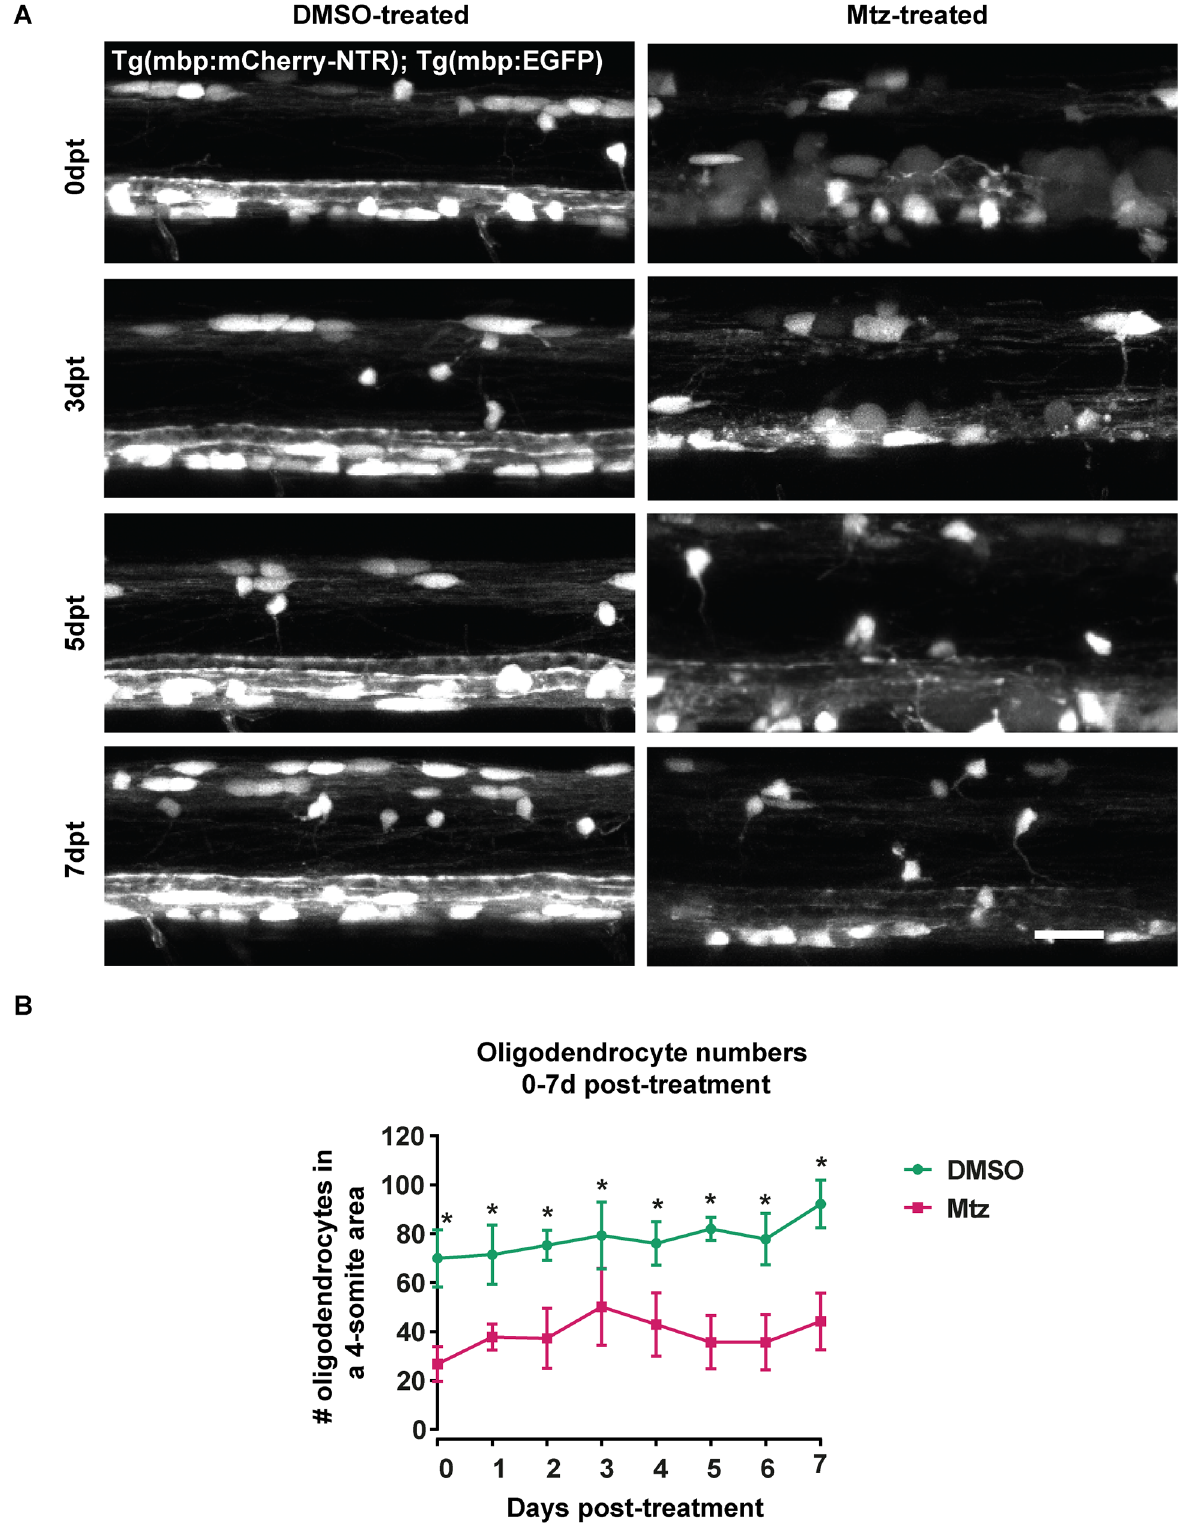
Fig 2. Oligodendrocyte numbers remain low in Mtz-treated Tg(mbp:mCherry-NTR) larvae for 7 days following treatment. A . Representative images from the spinal cords of DMSO- and Mtz-treated Tg(mbp:mCherry-NTR) larvae at the time points indicated; GFP